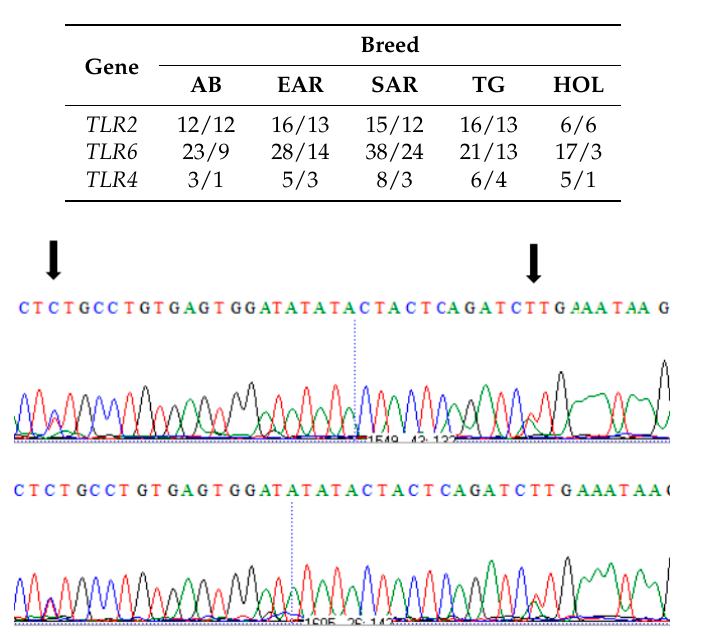
Table 2. InDel variants identified in TLR2 , TLR4 , and TLR6 genes. In each cell of the table, the total/novel number of variants is shown.